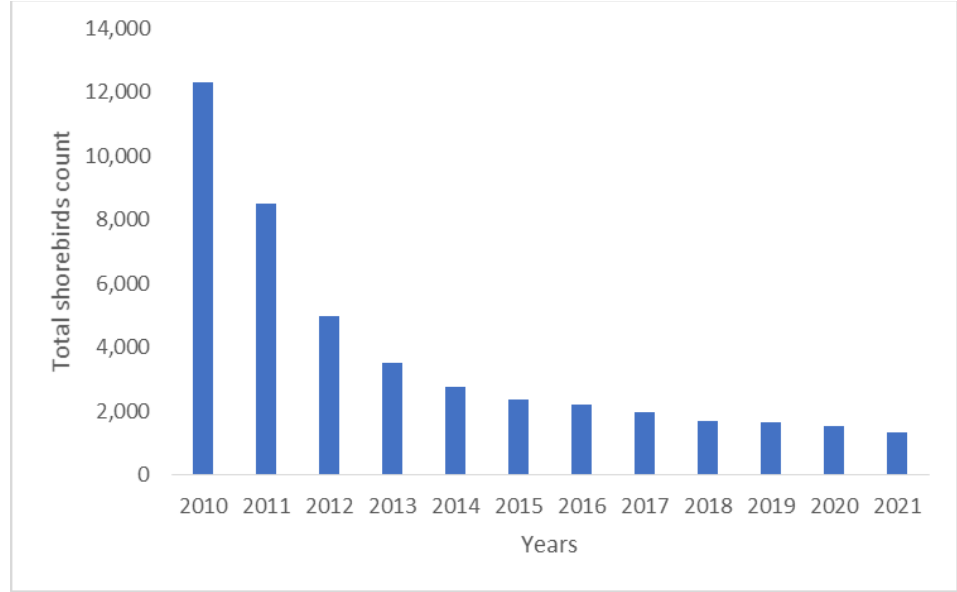
Figure 3. Variation in the counts of shorebirds over years at Kadalundi-Vallikkunnu Community Reserve, west coast of India — K.M. Aarif, (2010 – 2019) [14] and unpublished data 2020 –